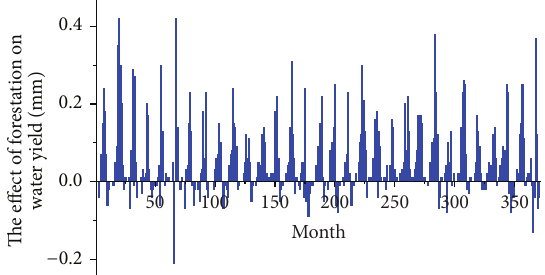
Figure 5: The difference of water yield between forestation scenario and baseline during